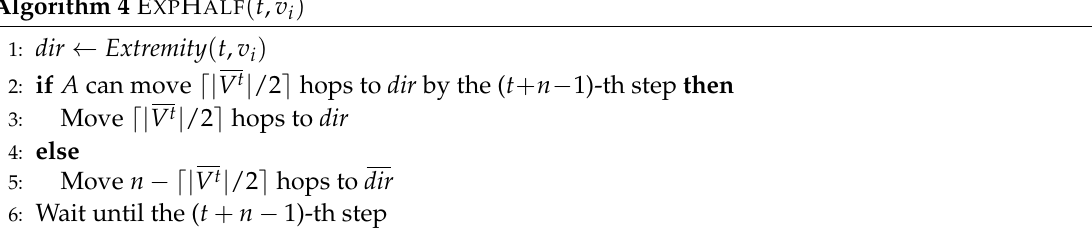
Figure 4. The moves of A by E XP H ALF ( t , v i ) where t (cid:48) = t + n − 1 in the case where v i is the right extremity of V t . ( a ) At the start of E XP H ALF ( t , v i ) , A exists on v i . ( b ) If A can reach v by i + | V t | /2 moving to right by the t (cid:48) -th step, A moves to right and reaches v by the t (cid:48) -th step. ( c ) Otherwise, i + | V t | /2 A moves to left and reaches v by the t (cid:48) -th step. i + | V t | /2 Algorithm 4 E XP H ALF ( t , v i